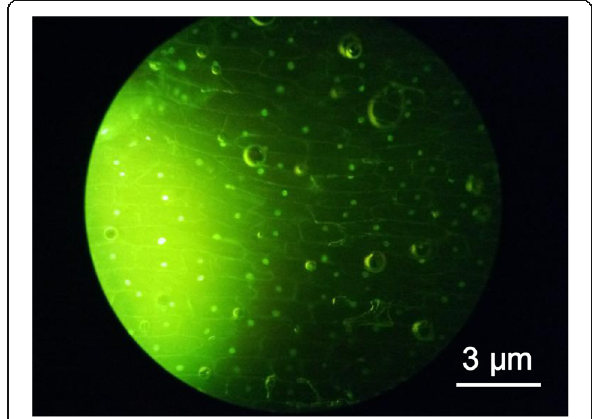
Fig. 5 An optic image of onion epidermal cells dyed using CQDs illuminated by a blue light